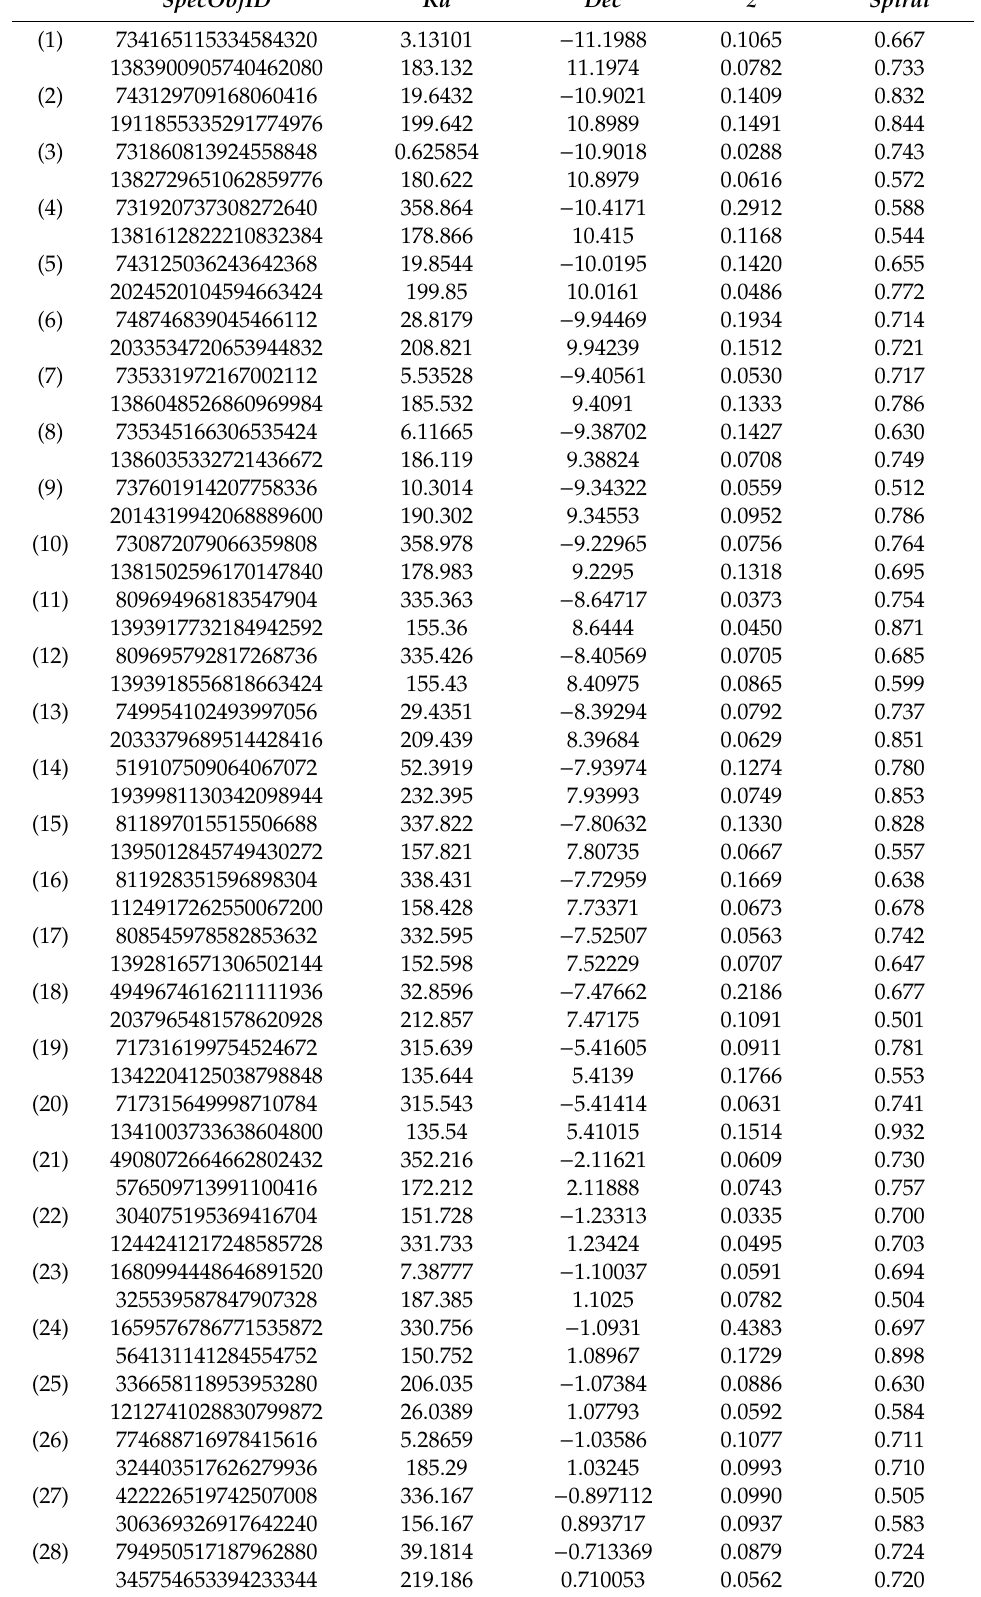
Table A10. Pairs of spiral galaxies (with parameter spiral > 0.5) for the e ff ect of cosmic mirror [39]—alternative approach. Accuracy is of 0.005 ◦ for ra and dec and z / 2 for z . SpecObjID is ID of optical spectroscopic object in